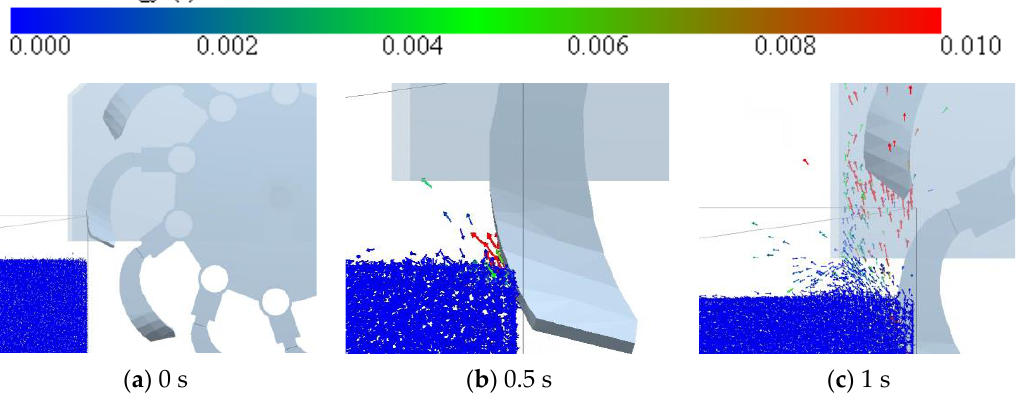
Figure 8. Soil cutting process. ( a ) the rotating tillage knife was not in contact with the soil. ( b ) the blade-side cutting edge began to contact the soil. ( c ) The contact area between the ditching knife cutter and the soil becomes larger.